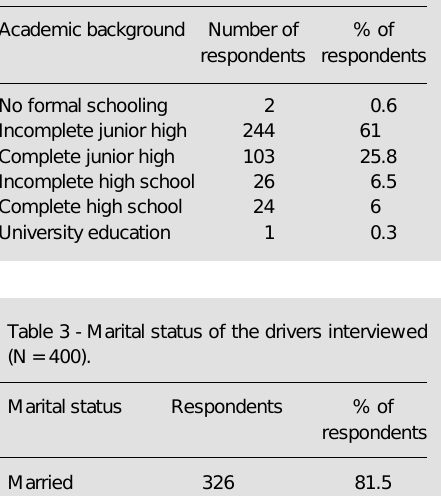
Table 2 - Academic background of the participants (N = 400).